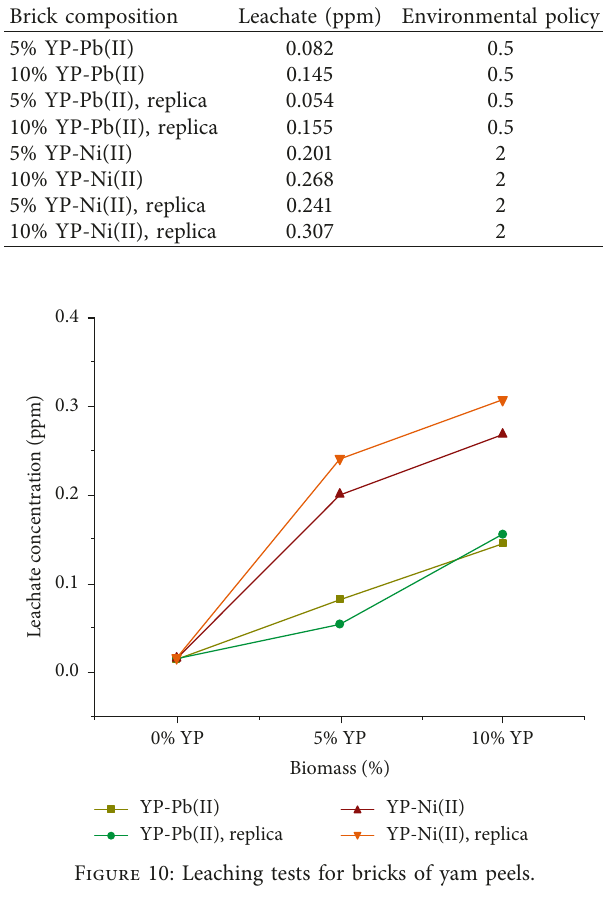
Figure 10: Leaching tests for bricks of yam peels.